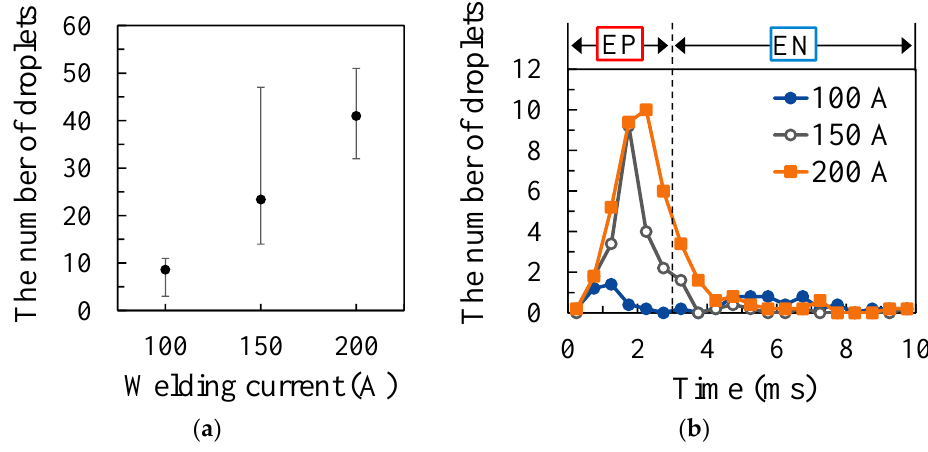
Figure 8. The number and timing of droplet ejection for different welding currents: ( a ) number of droplets; ( b ) timing of droplet ejections.